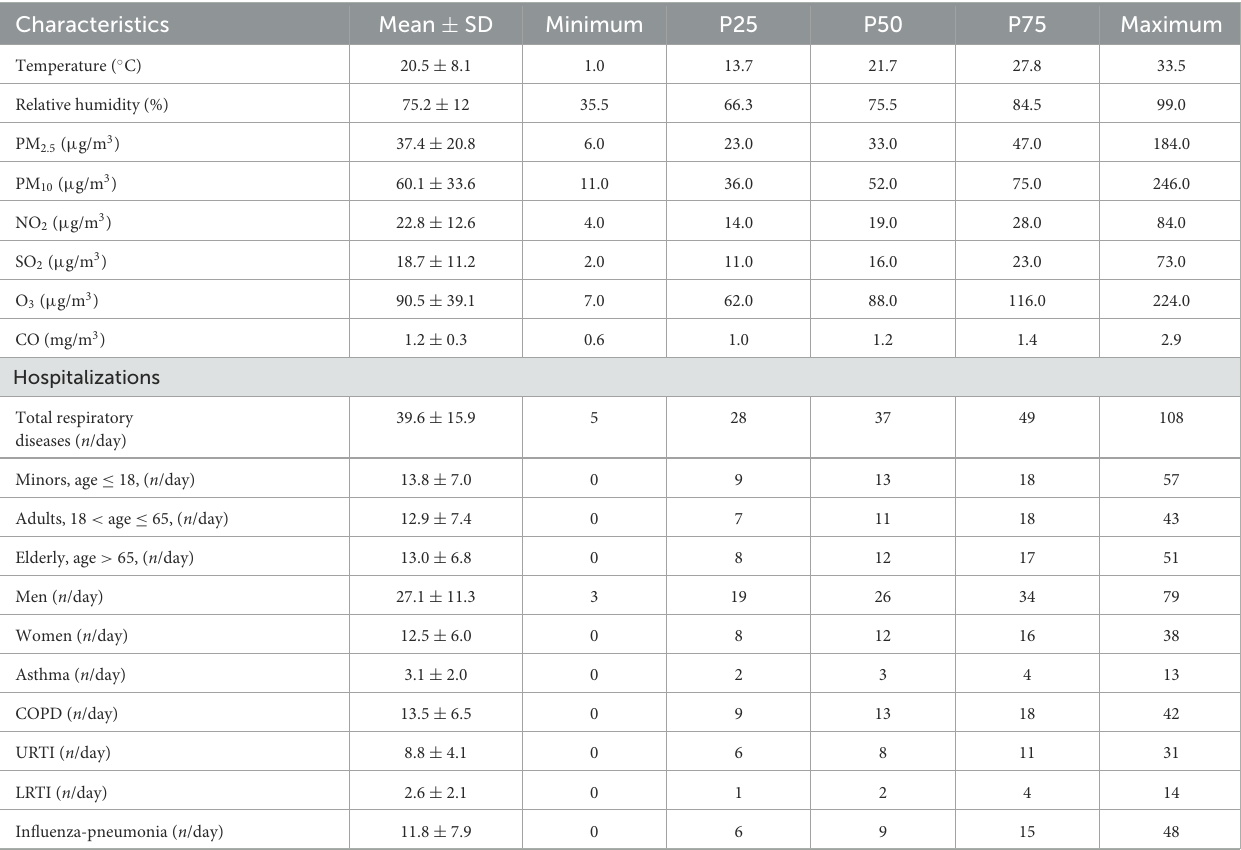
TABLE 1 Distribution of meteorological factors, air pollutants, and hospitalizations for respiratory diseases from 1 January 2016 to 31 December 2020 in Ganzhou.